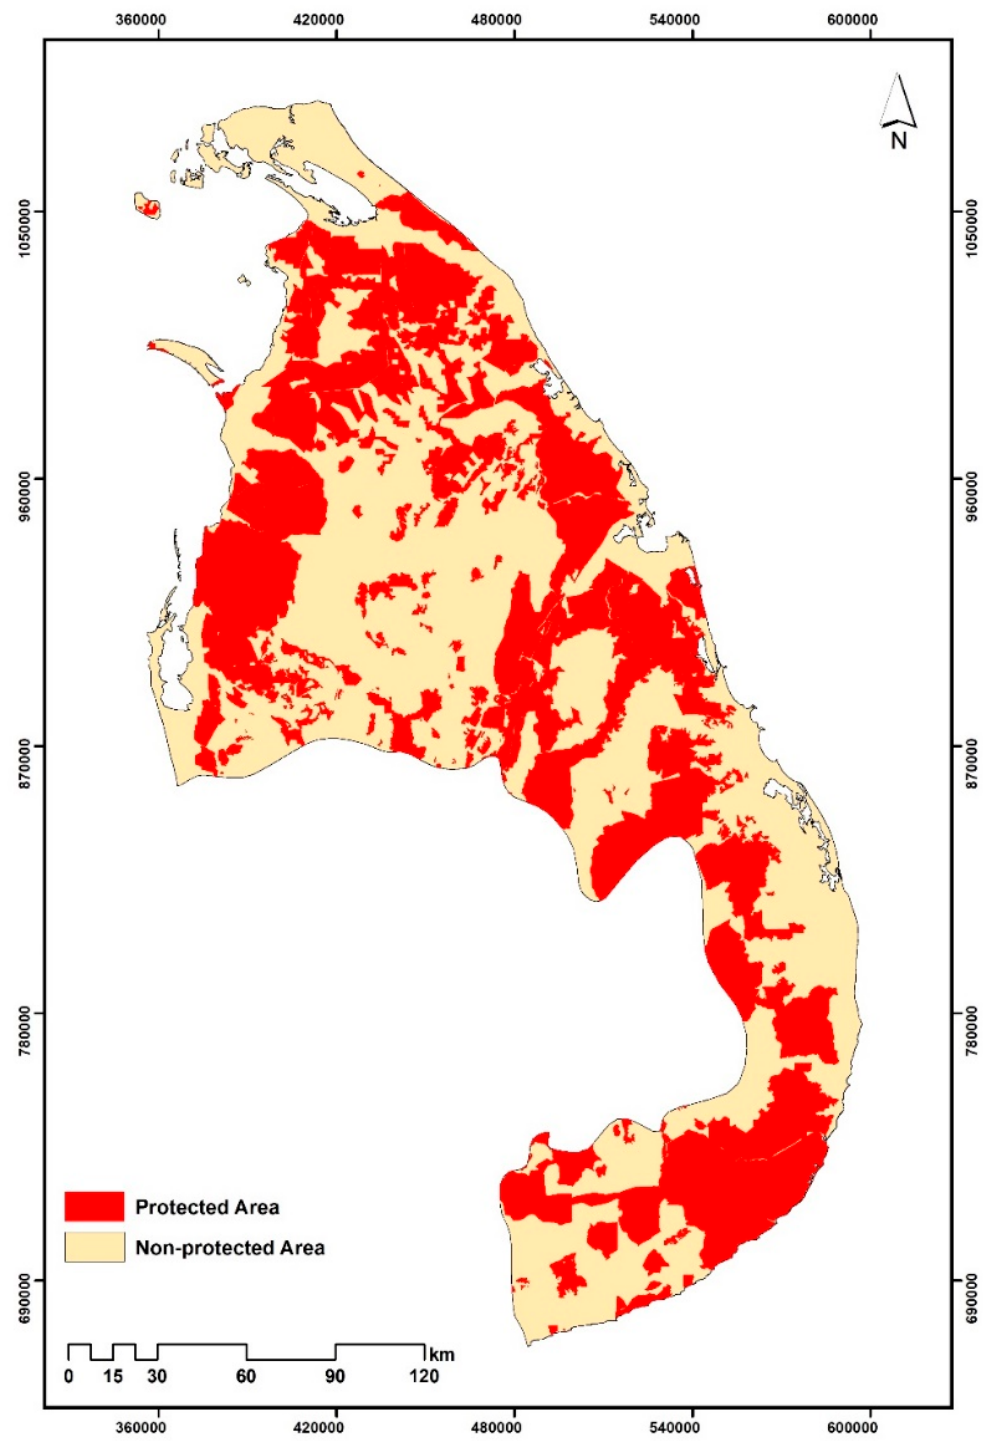
Figure A1. Protection area in the DZ, Sri Lanka.